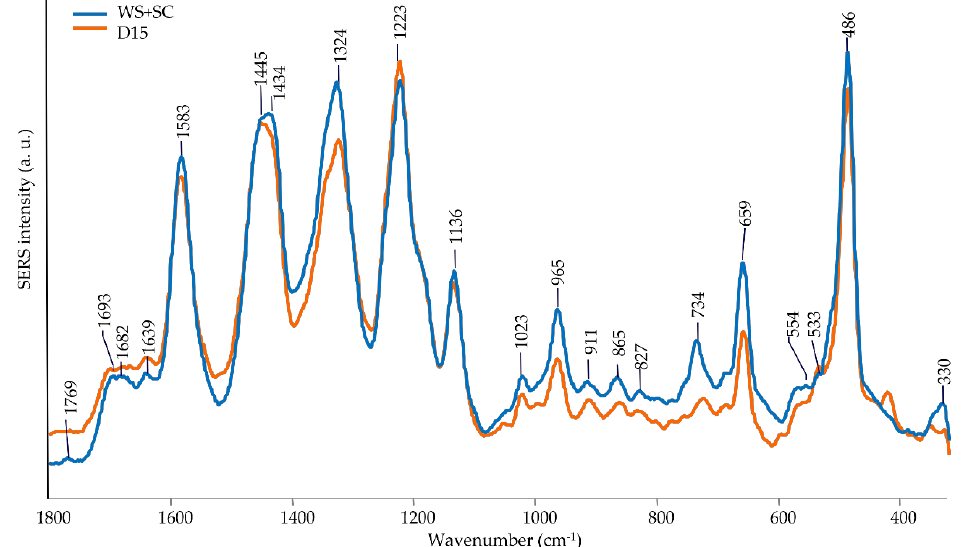
Figure 8. SERS spectra of the fruiting bodies of P. ostreatus harvested from the two growing substrates WS + SC (blue line) and D15 (orange line).